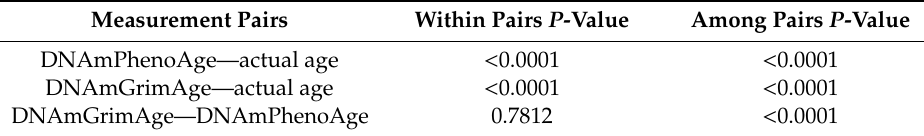
Table A4. Repeated measures test within and among groups.